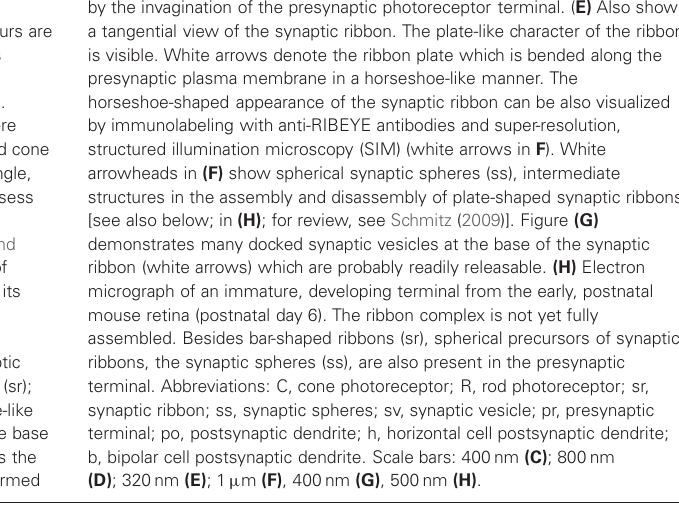
by the invagination of the presynaptic photoreceptor terminal. ( E) Also shows a tangential view of the synaptic ribbon. The plate-like character of the ribbon is visible. White arrows denote the ribbon plate which is bended along the presynaptic plasma membrane in a horseshoe-like manner. The horseshoe-shaped appearance of the synaptic ribbon can be also visualized by immunolabeling with anti-RIBEYE antibodies and super-resolution, structured illumination microscopy (SIM) (white arrows in F ). White arrowheads in (F) show spherical synaptic spheres (ss), intermediate structures in the assembly and disassembly of plate-shaped synaptic ribbons [see also below; in (H) ; for review, see Schmitz (2009)]. Figure (G) demonstrates many docked synaptic vesicles at the base of the synaptic ribbon (white arrows) which are probably readily releasable. (H) Electron micrograph of an immature, developing terminal from the early, postnatal mouse retina (postnatal day 6). The ribbon complex is not yet fully assembled. Besides bar-shaped ribbons (sr), spherical precursors of synaptic ribbons, the synaptic spheres (ss), are also present in the presynaptic terminal. Abbreviations: C, cone photoreceptor; R, rod photoreceptor; sr, synaptic ribbon; ss, synaptic spheres; sv, synaptic vesicle; pr, presynaptic terminal; po, postsynaptic dendrite; h, horizontal cell postsynaptic dendrite; b, bipolar cell postsynaptic dendrite. Scale bars: 400nm (C) ; 800nm (D) ; 320nm (E) ; 1 μ m (F) , 400nm (G) , 500nm (H)